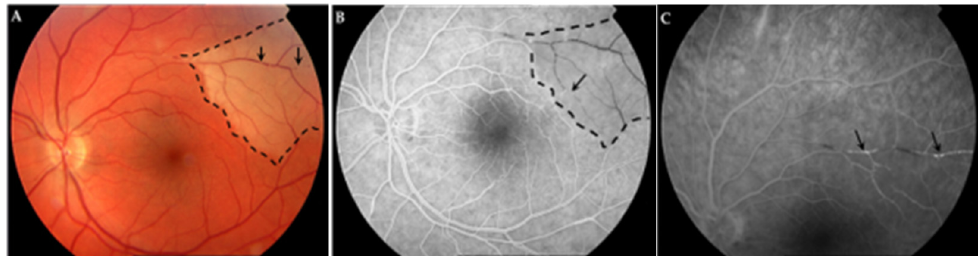
Figure 2. ( A ). Retinography: retinal edema in the upper temporal zone (dash line) with arterial occlusions (arrows). ( B ). Fluorescein angiography: area of retinal non-perfusion in the superior temporal zone (dash line) with segmental occlusions in arterial vessel (arrow). ( C ). Fluorescein angiography (late times): upper vessel hyperfluorescence reflecting inflammation